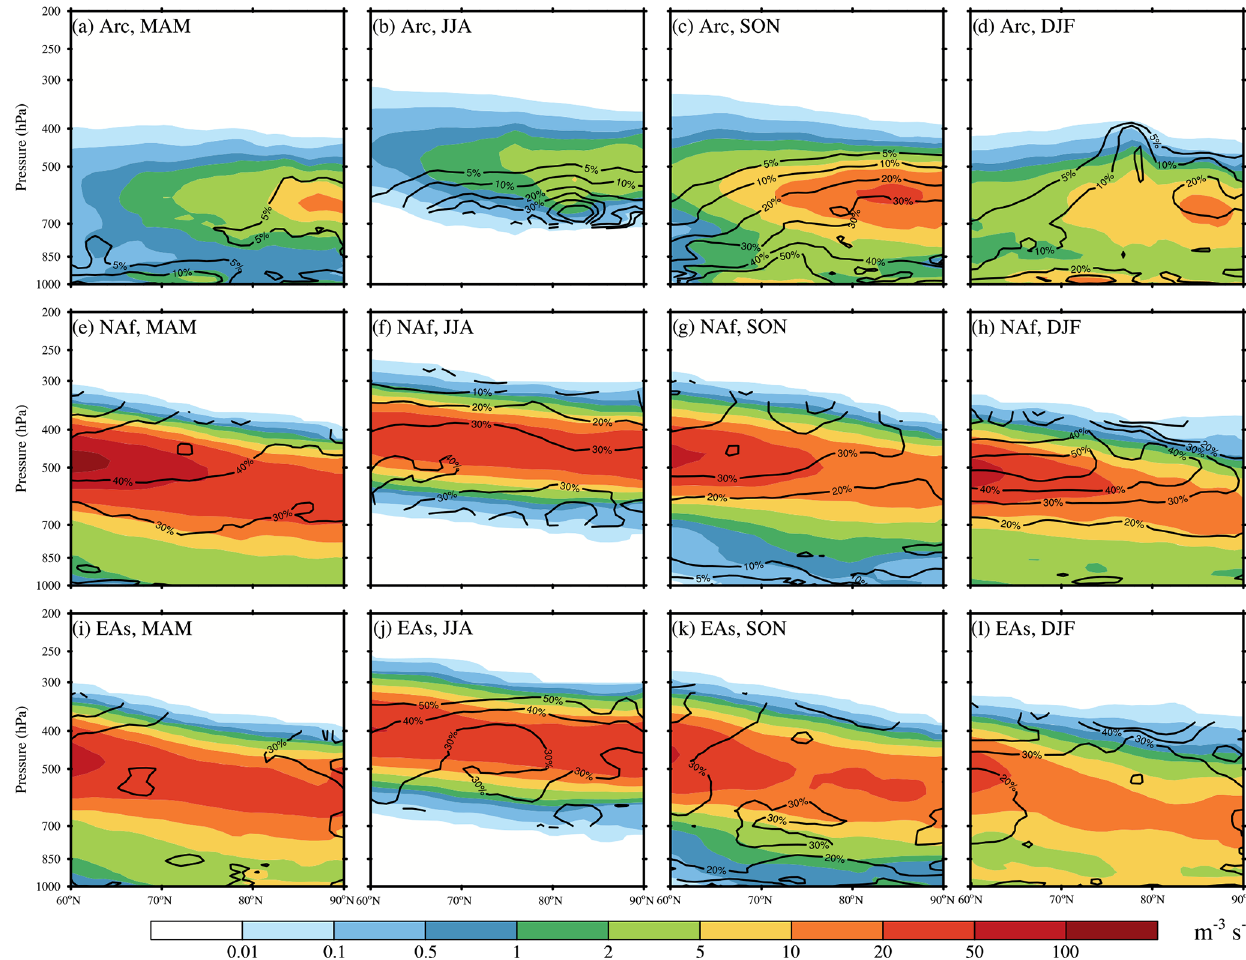
Figure 10. Seasonal variations (year 2007 to 2011) of the mixed-phase clouds immersion freezing rates (unit: m − 3 s − 1 ) over the Arctic for dust emitted from the Arctic (a–d) , North Africa (e–h) , and East Asia (i–l) . Black contours are the percentage contributions from each dust source to the total immersion freezing rate in the corresponding